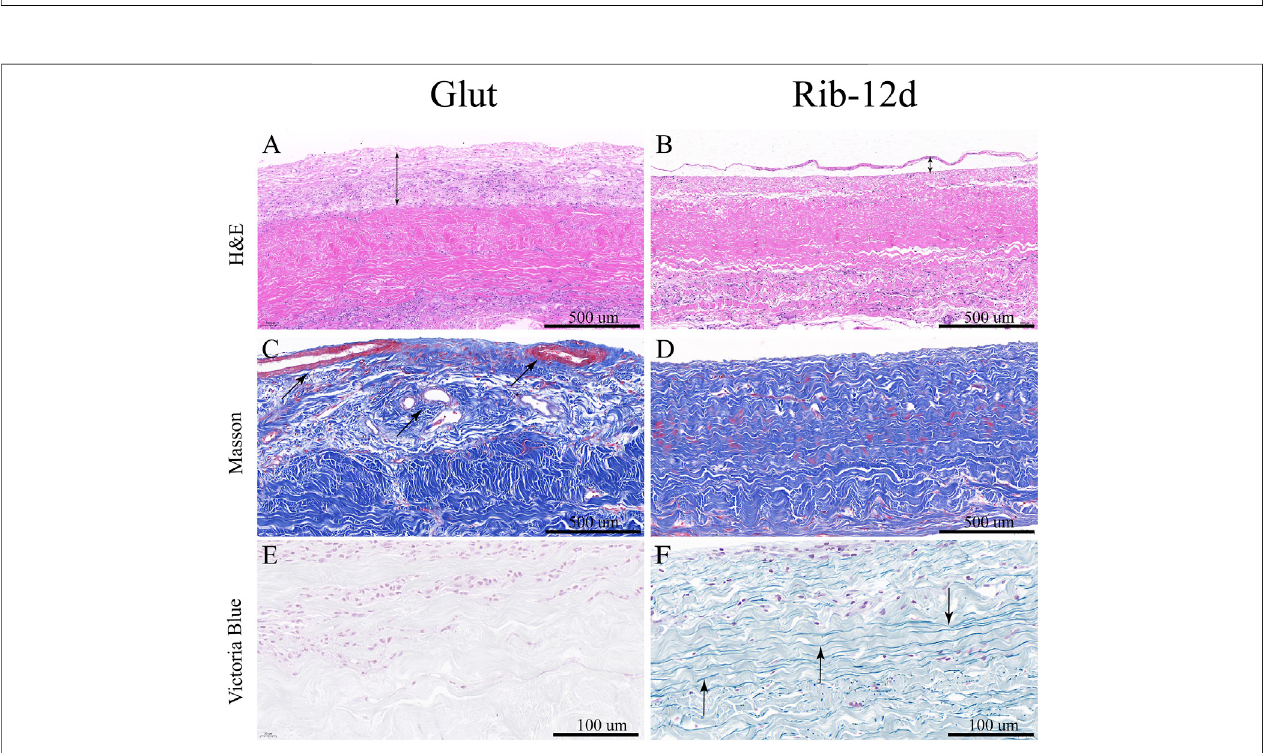
FIGURE 10 | ECM integrity and histological staining after implanted into rats for 90 days. (A,B) H&E staining of the BP. Nuclei were stained purple, and the cytoplasmwasstainedpink.Thethicknessofthe fi brouscapsule(blackdouble-arrow). (C,D) MTstainingoftheBPandthecollagenarestainedblue,andnewcapillary- like tubes are stained red (black arrow). (E,F) Victoria Blue staining of the BP. Elastin fi bers were stained dark blue stripes (black arrow). Scale bars: 500 μ m (A – D) and 100 μ m (E,F) .